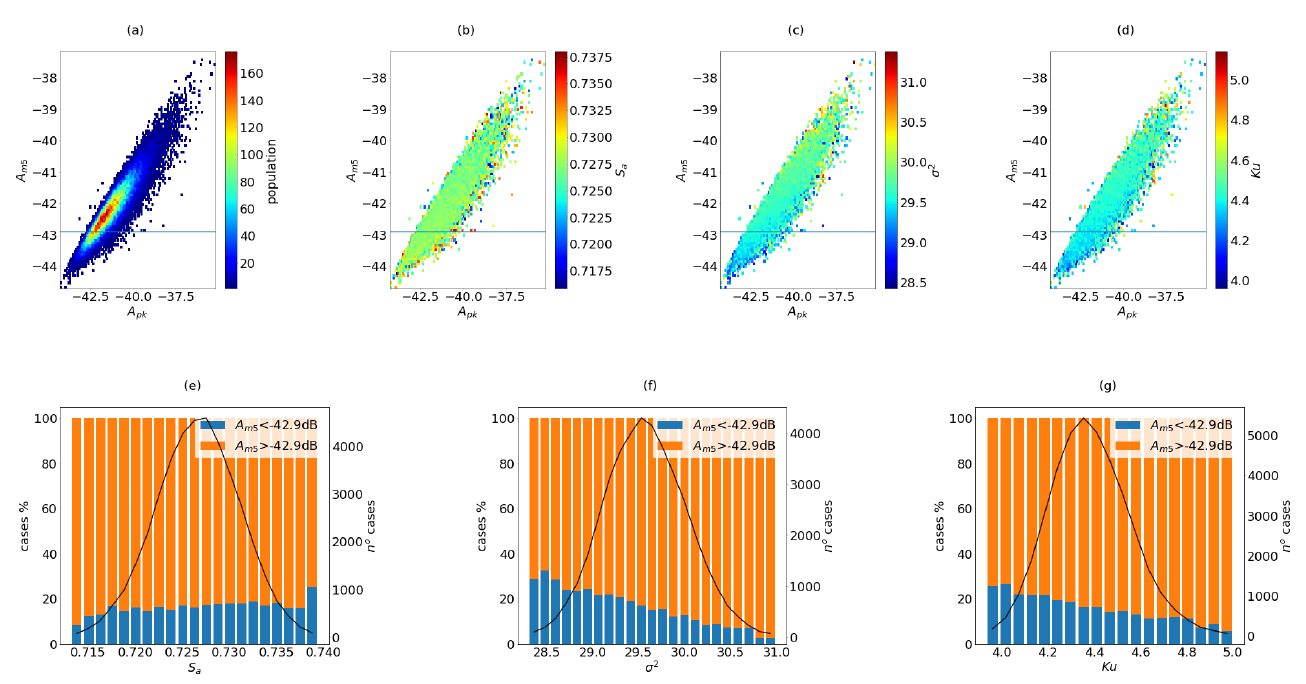
Figure 7. Results of 50,000 random cases of configuration 196I. In the first row, the apertures are presented in A m 5 vs. A pk map, ( a ) population, ( b ) S a , ( c ) σ 2 and ( d ) Ku . In the second row, the distribution of cases against the coarray parameters are presented, threshold, ( e ) S a , ( f ) σ 2 and ( g ) Ku marking the proportion of case that fulfill the TH A m 5